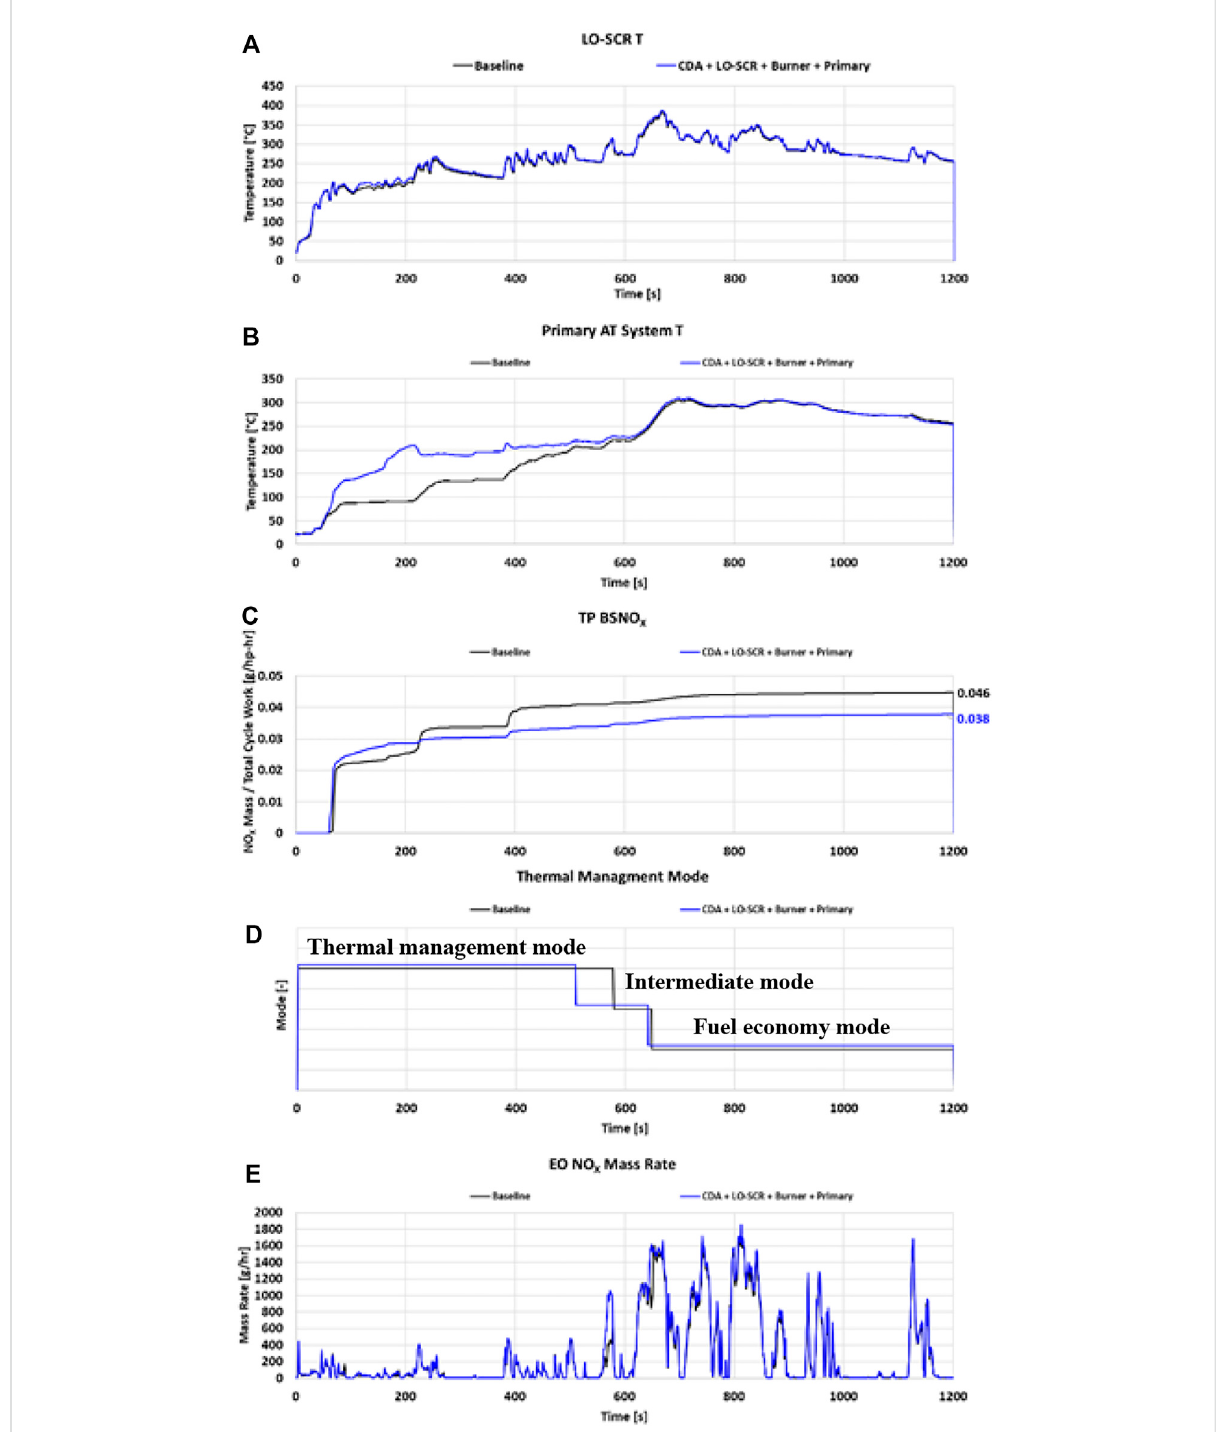
FIGURE 6 ColdstartHD-FTPmeasurementcomparisonsbetweentheBaselineandCDA+LO-SCR+Burner+Primarysystems. (A) LO-SCRtemperature, (B) primary system temperature, (C) cumulative TP BSNO X , (D) engine mode comparison, (E) engine outlet NO X mass